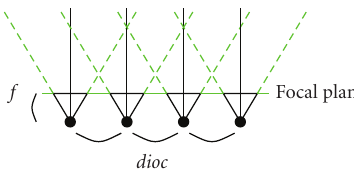
Figure 1: Illustration of the parallel camera configuration with four optics (illustrated by black